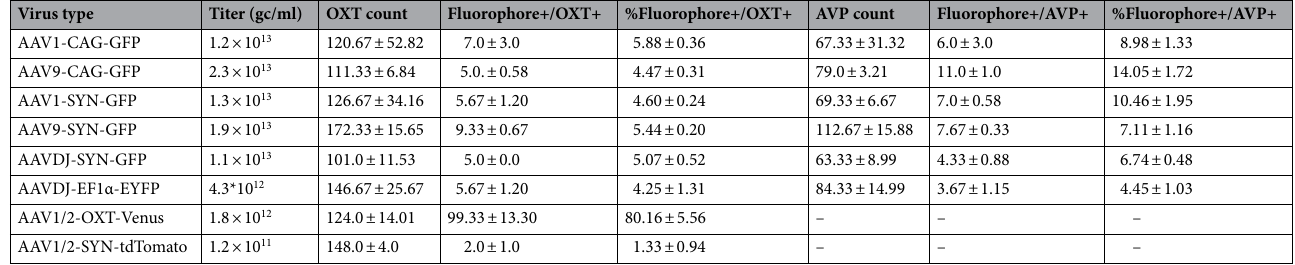
Table 2. Viral titers and counts for